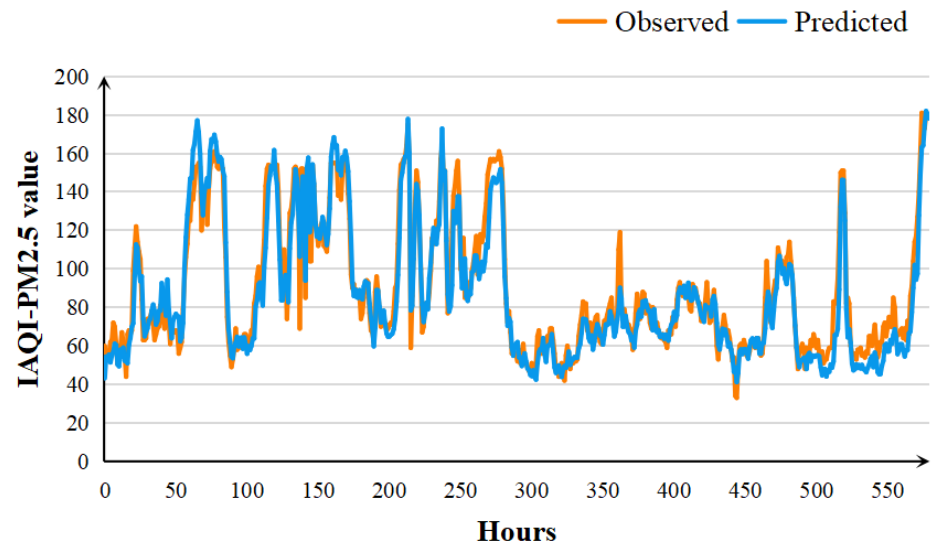
Figure 11. ST-CCN-IAQI prediction fitting figure for Single station IAQI-PM 2.5 .